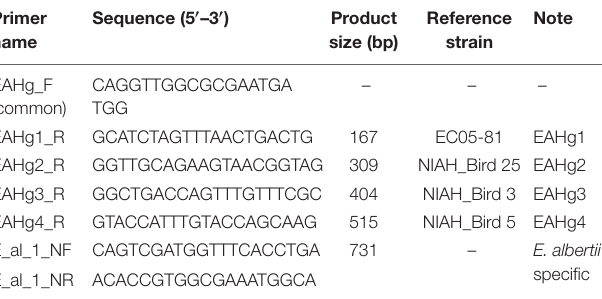
TABLE 1 | Primer information for EAH-genotyping